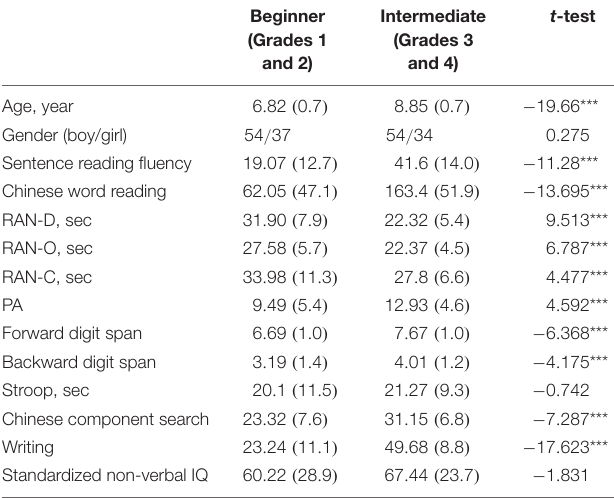
TABLE 1 | Demographic characteristics of the participants and descriptive statistics of the